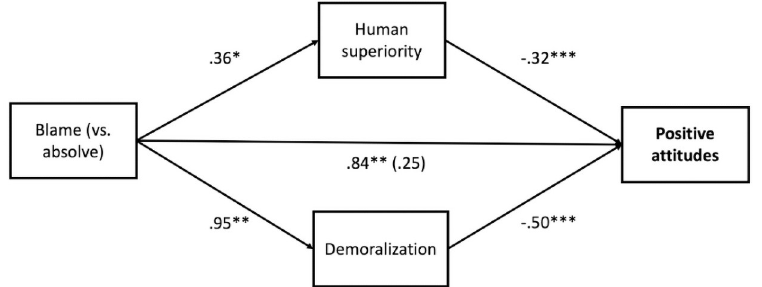
Fig 1. Model testing the effect of condition (blame vs. absolve) on positive attitudes towards veg � nism through human superiority beliefs and demoralization for Study 1. Note . Unstandardized coefficients displayed. � p < .05, �� p < .01, ��� , p < .001, two-tailed tests.